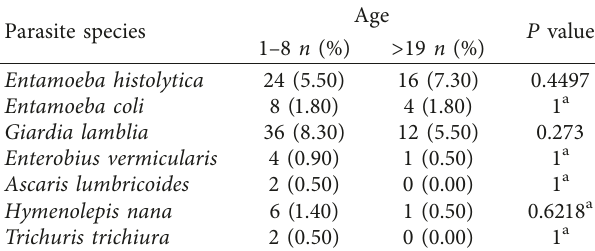
Figure 6: (a, b) Parasitic infection rate according to the age of participants. Note . Table 2: Summarizing the distribution of parasitic species among participants according to